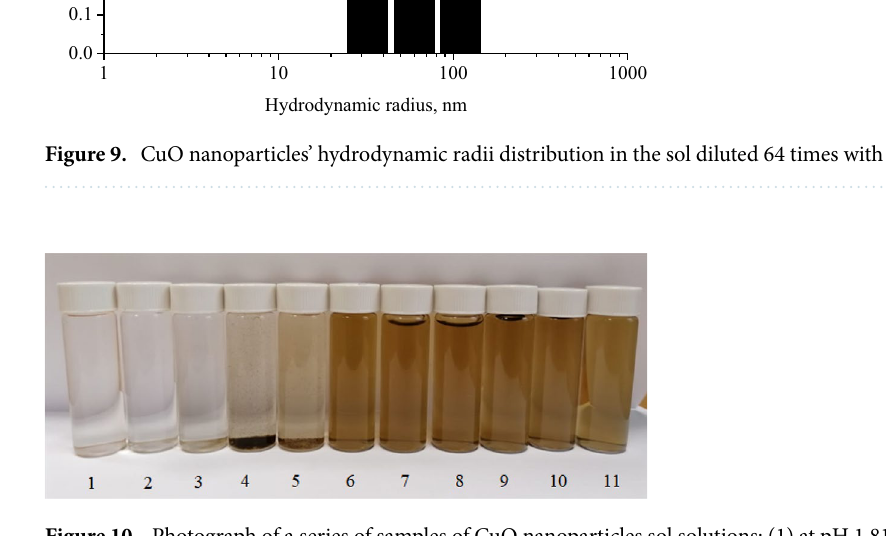
Figure 10. Photograph of a series of samples of CuO nanoparticles sol solutions: (1) at pH 1.81, (2) at pH 2.21, (3) at pH 3.29, (4) at pH 4.56, (5) at pH 5.72, (6) at pH 6.8, (7) at pH 7.96, (8) at pH 9.15, (9) at pH 10.38, (10) at pH 11.58, (11) at pH